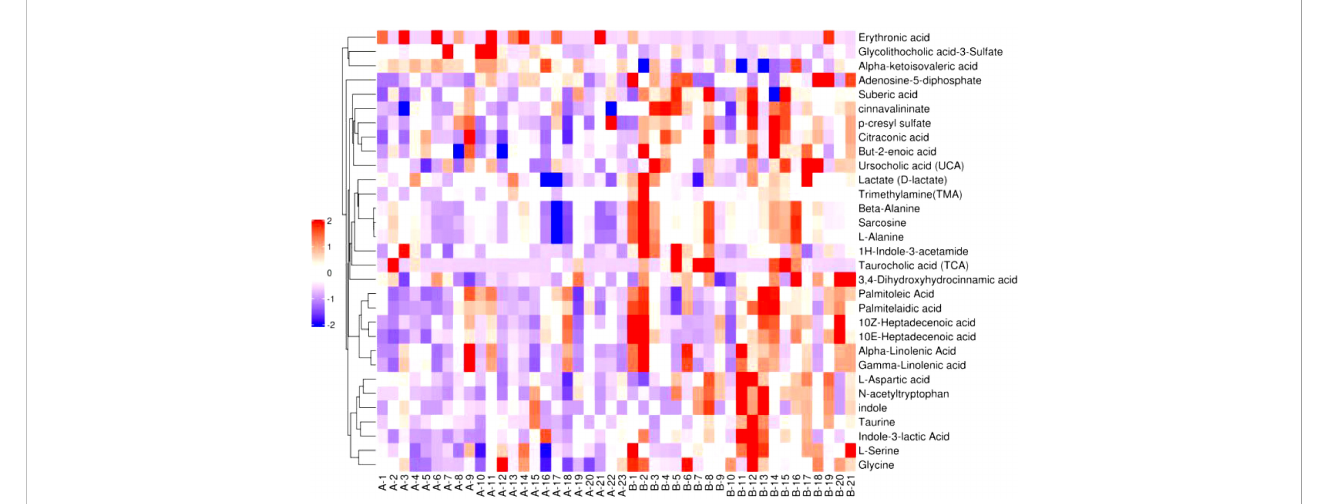
FIGURE 6 Heatmap of metabolites with signi fi cant difference between treatment group and placebo.